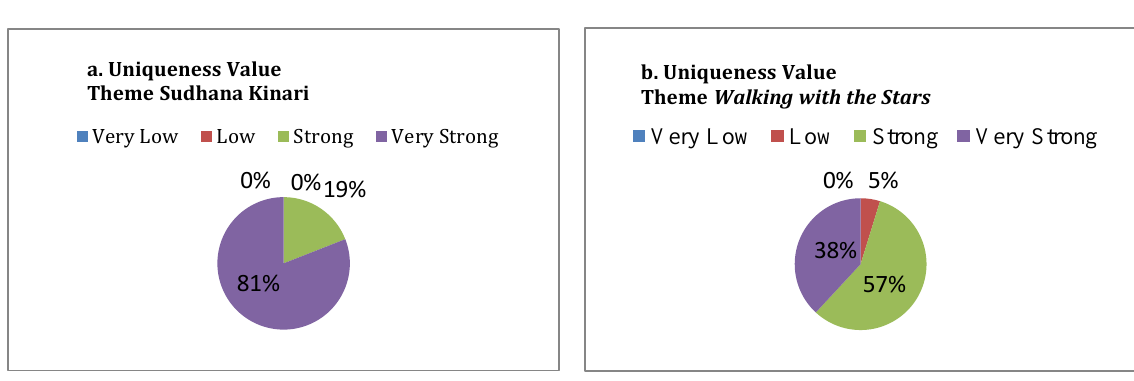
Fig. 3 Uniqueness Value Theme 1; a Sudhana Kinari , b Walking with the Stars